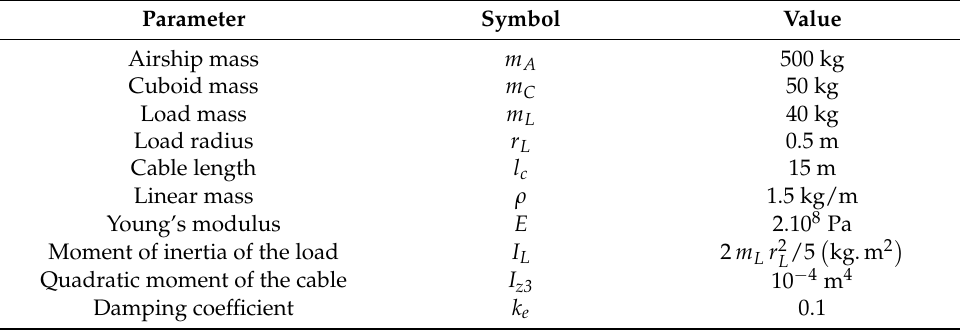
Table 1. Characteristics of the different elements of the system.